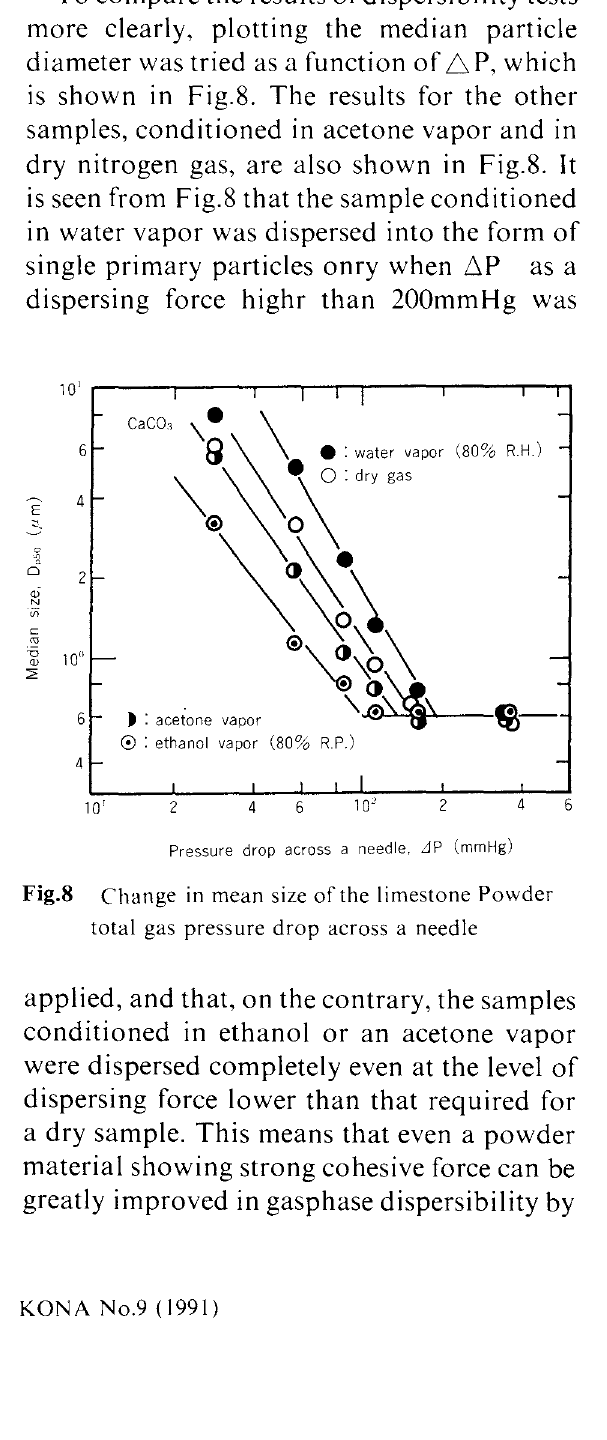
Fig.9 Change in meen size of the limestone powder with total gas pressure drop across a